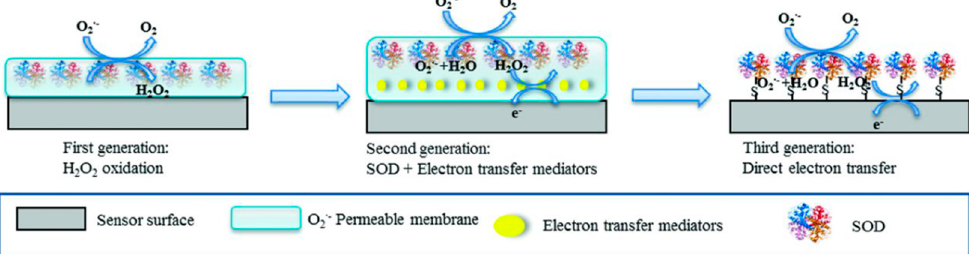
Figure 1. Schematic illustration of first, second and third generation biosensors, exemplified for biosensors based on superoxide dismutase (SOD) for the detection of superoxide anion. Reproduced from [1] with permission.